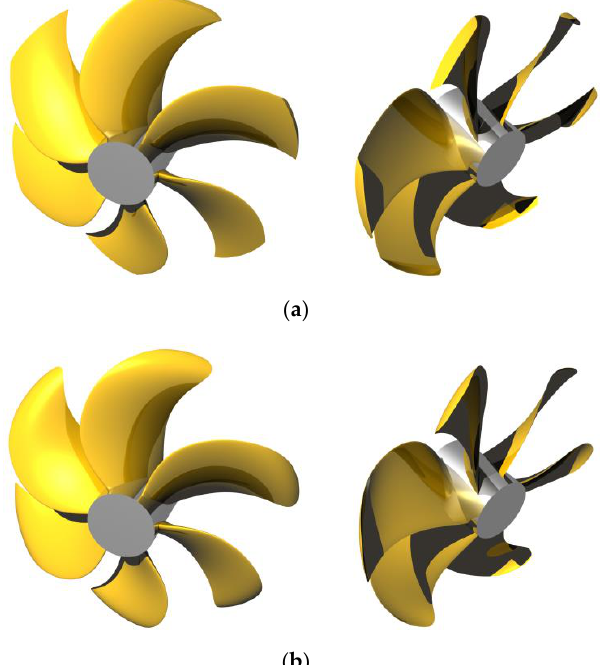
Figure 1. Tip-loaded propeller test cases. ( a ) Conventional CLT propeller; ( b ) New Generation CLT The main geometrical characteristics of the two propellers are given in Table 1. Since they share the same functioning conditions and come from the same reference ge- ometry, they are extremely similar. Both are six-bladed, right-handed propellers, with (the same) moderate skew at the tip and almost identical values of expanded area ratio, chord and pitch (reference at 0.7R), which are very similar when also looking at their ra- dial distributions. The most relevant difference, as discussed, is in the rake used in the new generation CLT concept to realize the tip bending (towards the pressure side) con- venient for the tip loading. Table 1. Main geometrical characteristics of the test case propellers. Conventional CLT